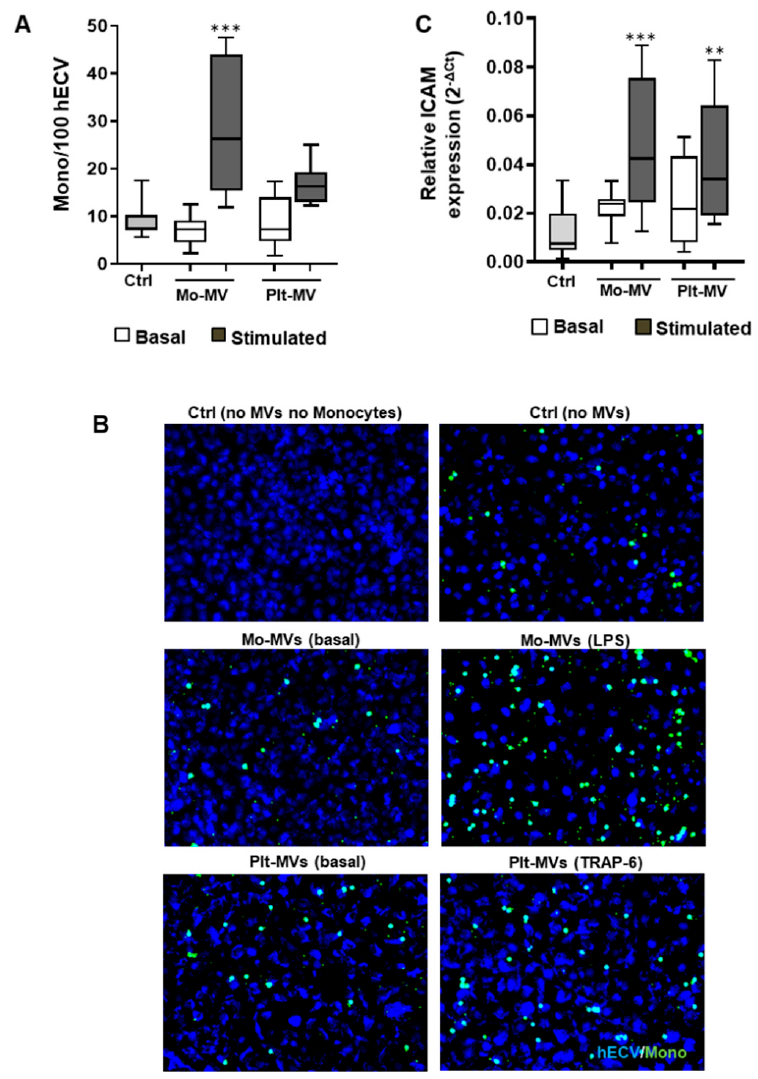
Figure 4. MV effects on monocytes adhesion to endothelial cells. hECV were stimulated for 6 h with MVs released from monocytes (Mo-MV) and platelets (Plt-MV) isolated from healthy subjects, at resting conditions (basal) or stimulated with LPS (10 µg/mL) or TRAP-6 (20 µM), respectively. ( A ) hECV cells were challenged 1 h with 200 MV/µL and then incubated 1 h 30 min with monocytes stained with calcein. Number of monocytes on hECV was quantified by ImageJ fluorescence. Data are represented in box and whisker plot (min to max) and are expressed as number of adherent monocytes on 100 hECV cells. ( B ) Representative images of adhesion assay: hECV nuclei stained with DAPI, monocytes stained by calcein, magnification 200 × . ( C ) ICAM gene expression. Data are represented in box and whisker plot (min to max) of 2- ∆ Ct and analyzed by one-way ANOVA with Dunnett’s test for multiple comparisons. n = 8 experiments. ** p < 0.01; *** p < 0.001 vs. untreated control (Ctrl).